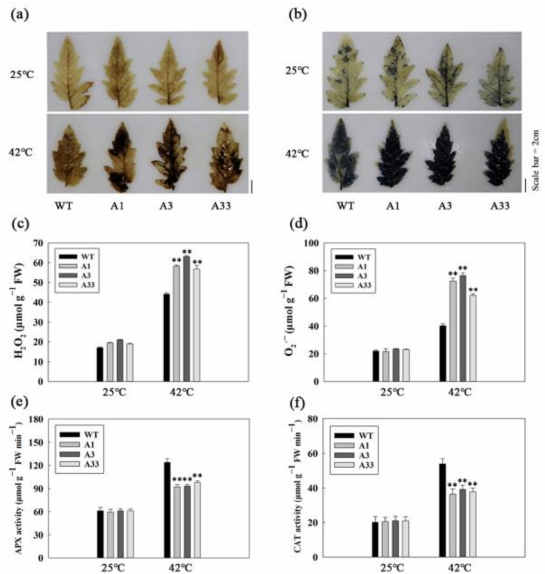
Figure 7. DAB ( a ) staining, NBT staining ( b ), H 2 O 2 content ( c ), O 2 •− content ( d ) and activities of APX ( e ) and CAT ( f ) in WT and AS lines. ** ( p < 0.01) indicate significant differences relative to the WT